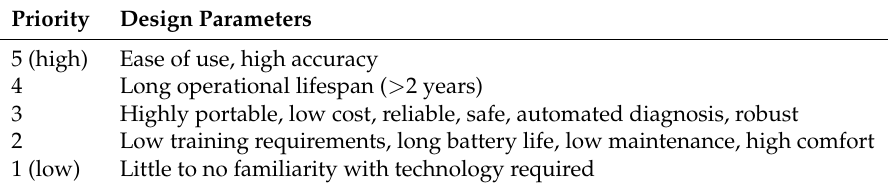
Table 1. UNICEF design